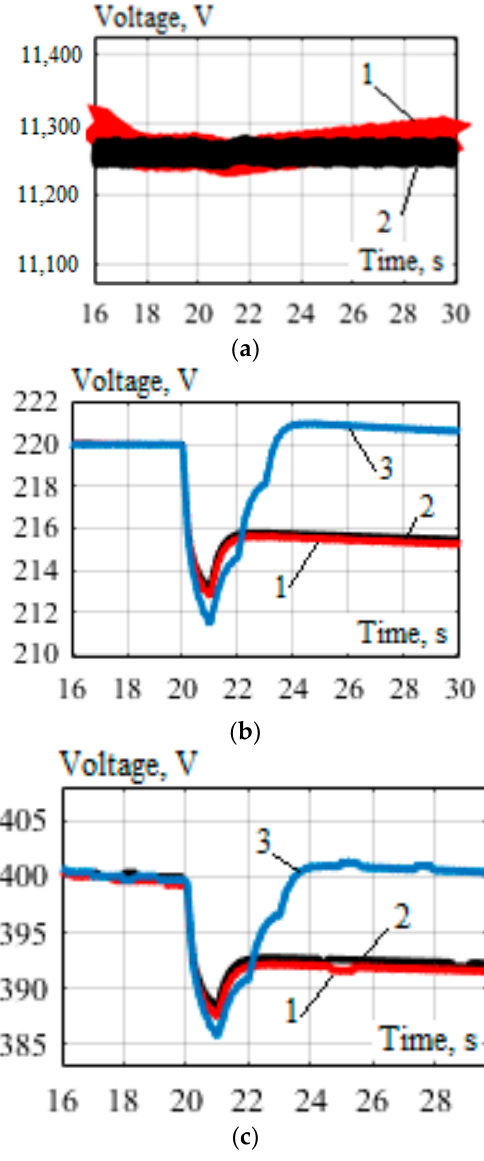
Figure 13. Time dependencies for voltages: ( a ) on the HV side of the PR; ( b ) on the LV side of the PR (DC grid); ( c ) on the LV side of the PR downstream of the inverter (in the AC grid); 1—non-regulated PRs; 2—regulated PRs; 3—regulated PRs when connected in series in the 220 V grid. Table 2. Voltage sag simulation results with a heavy load